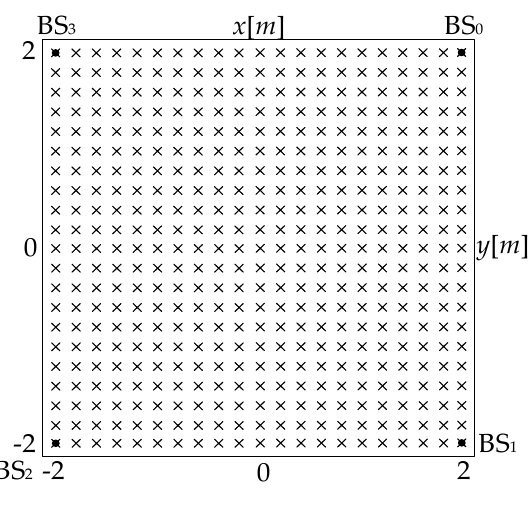
Figure 8. Setup of the source and BSs.